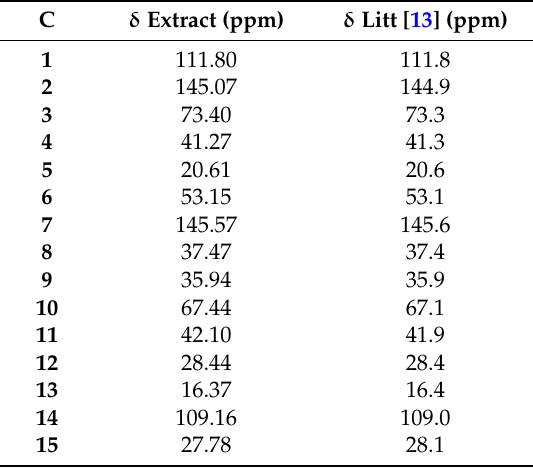
Table 1. Chemical shifts of β -snyderol in CDCl 3